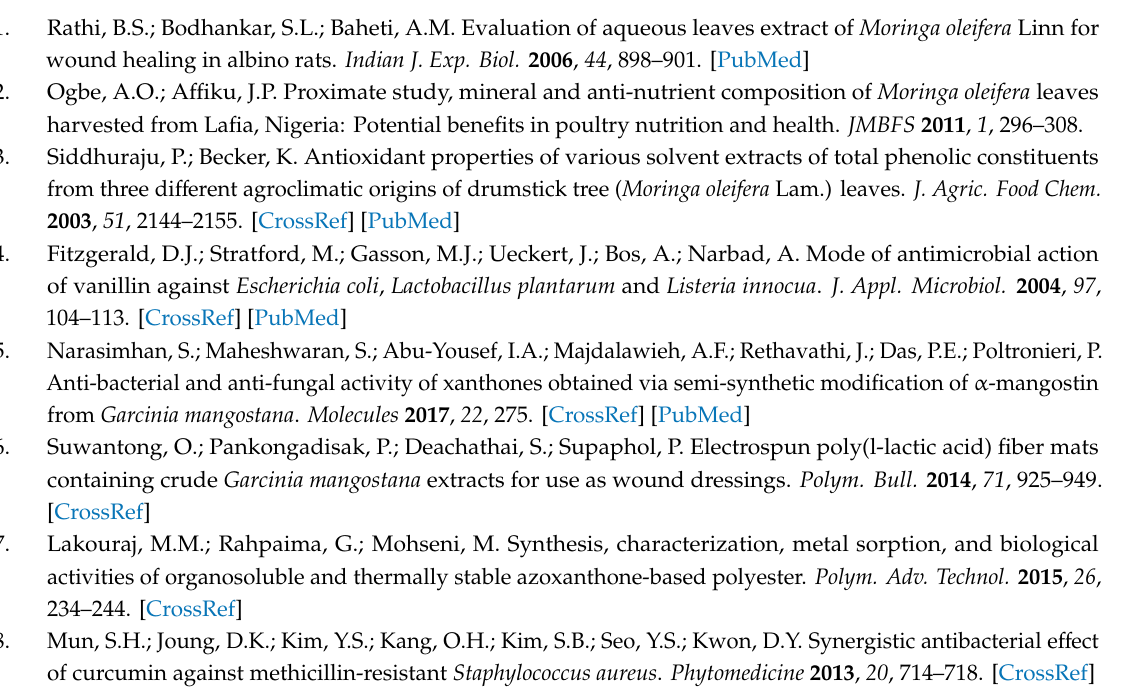
Figure S1: Chemical structures of ca ff eoylquinic acid, feruloylquinic acid, tannins, gallic acid, quercetin,